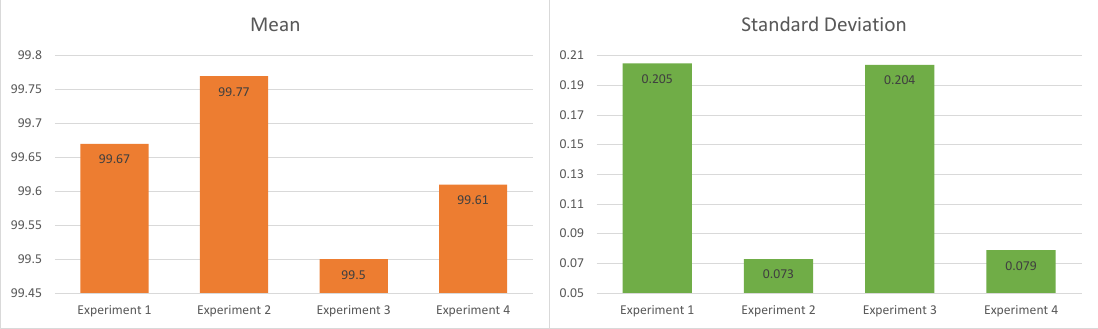
Figure 11. Means and standard deviations of ten tests on the four experiments.